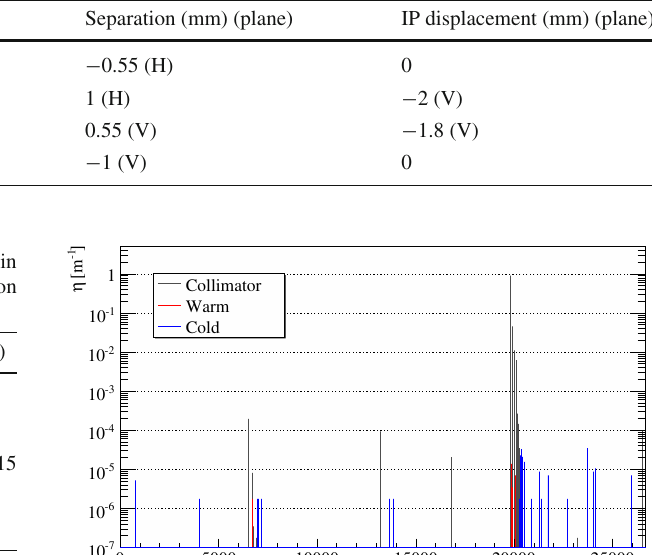
Table 3 LHC operational parameters in 2018 at End of Squeeze IP